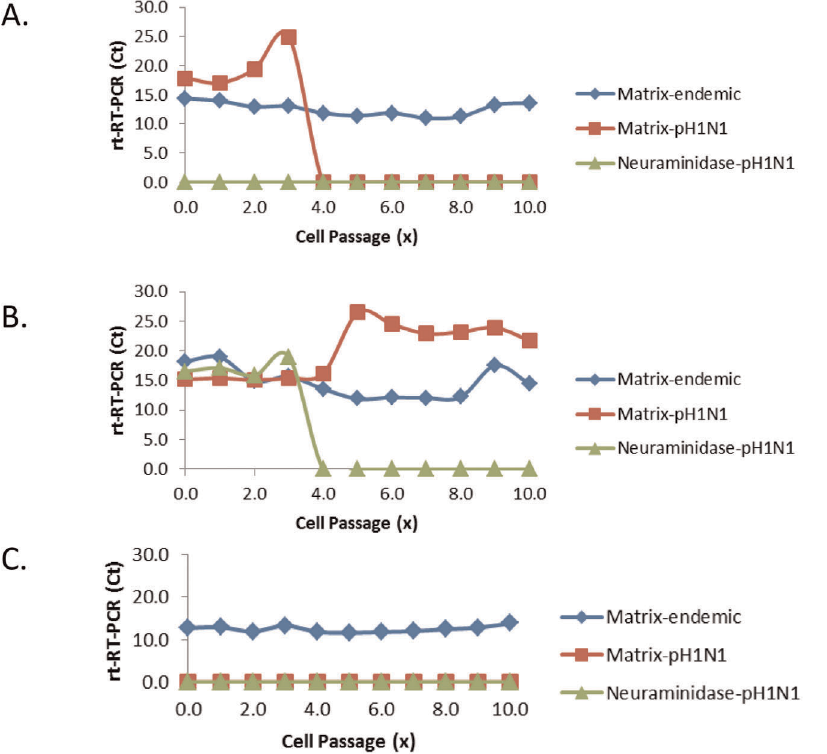
Figure 1. Flasks of ST cells were coinfected with H1N2 and pH1N1 with multiplicities of infection of 1:1 (A), 0.1:1.0 (B), and 1.0:0.1 (C) of H1N2/pH1N1, respectively. The presence of the matrix genes derived from either H1N2 or pH1N1 as well as the neuraminidase derived from pH1N1 were quantified by rt-RT-PCR using gene specific primers and probes.